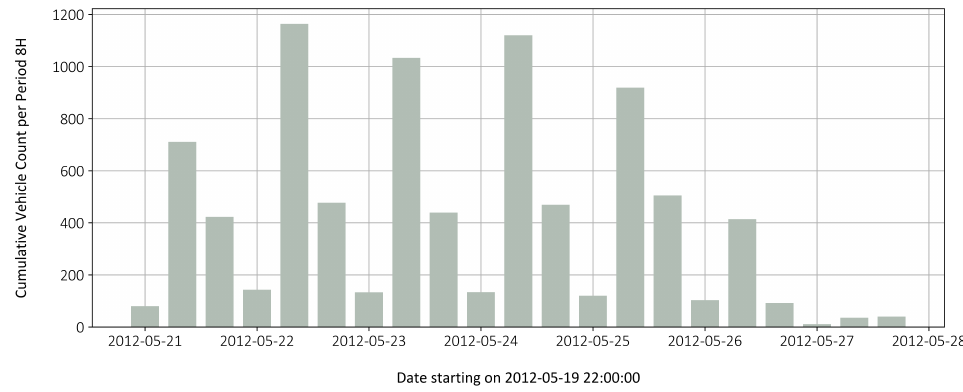
Figure 12. Heavy vehicle count during 4th week of May 2012, two lanes towards